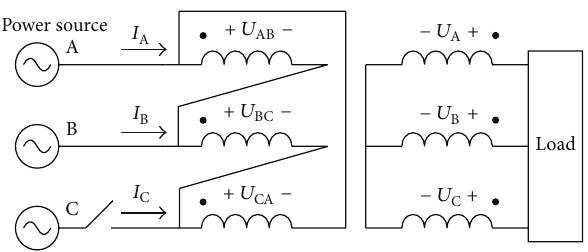
Figure 6: The two-phase-powered model of the delta/wye trans- former.